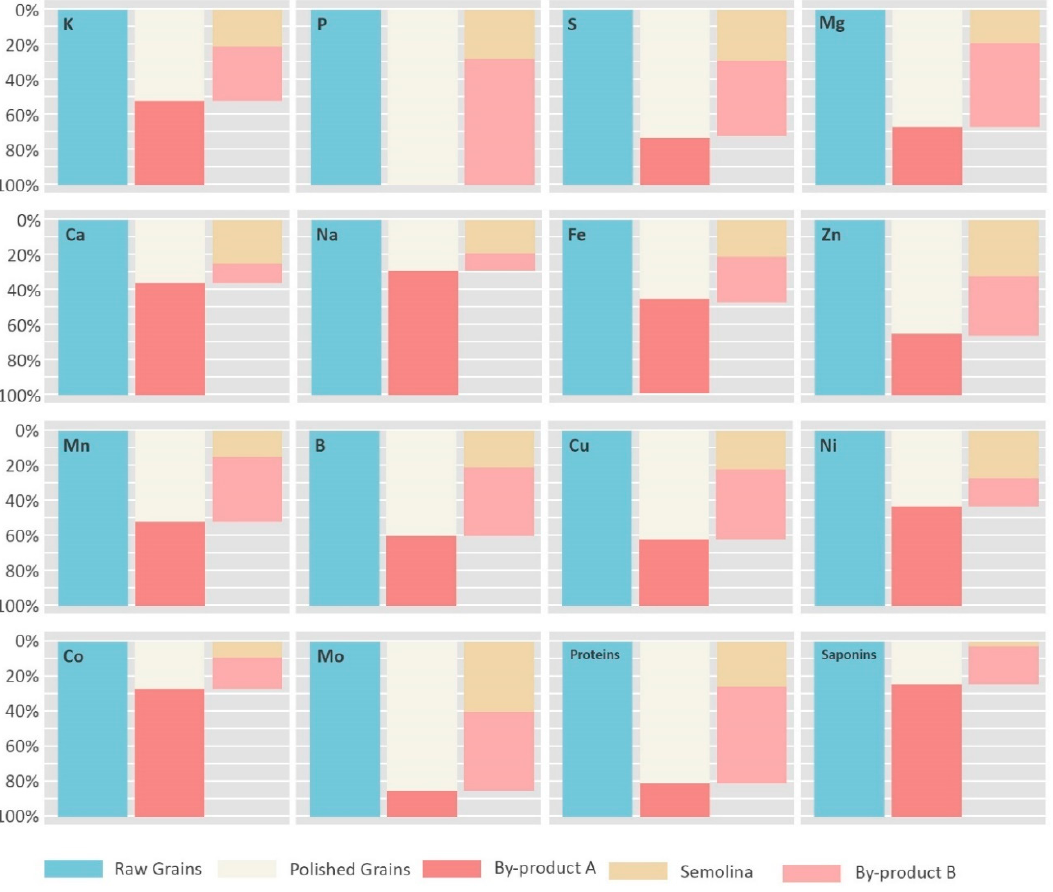
Figure 4. Minerals, proteins, and saponins proportions in different quinoa fractions and by-products generated through the different processing forms.